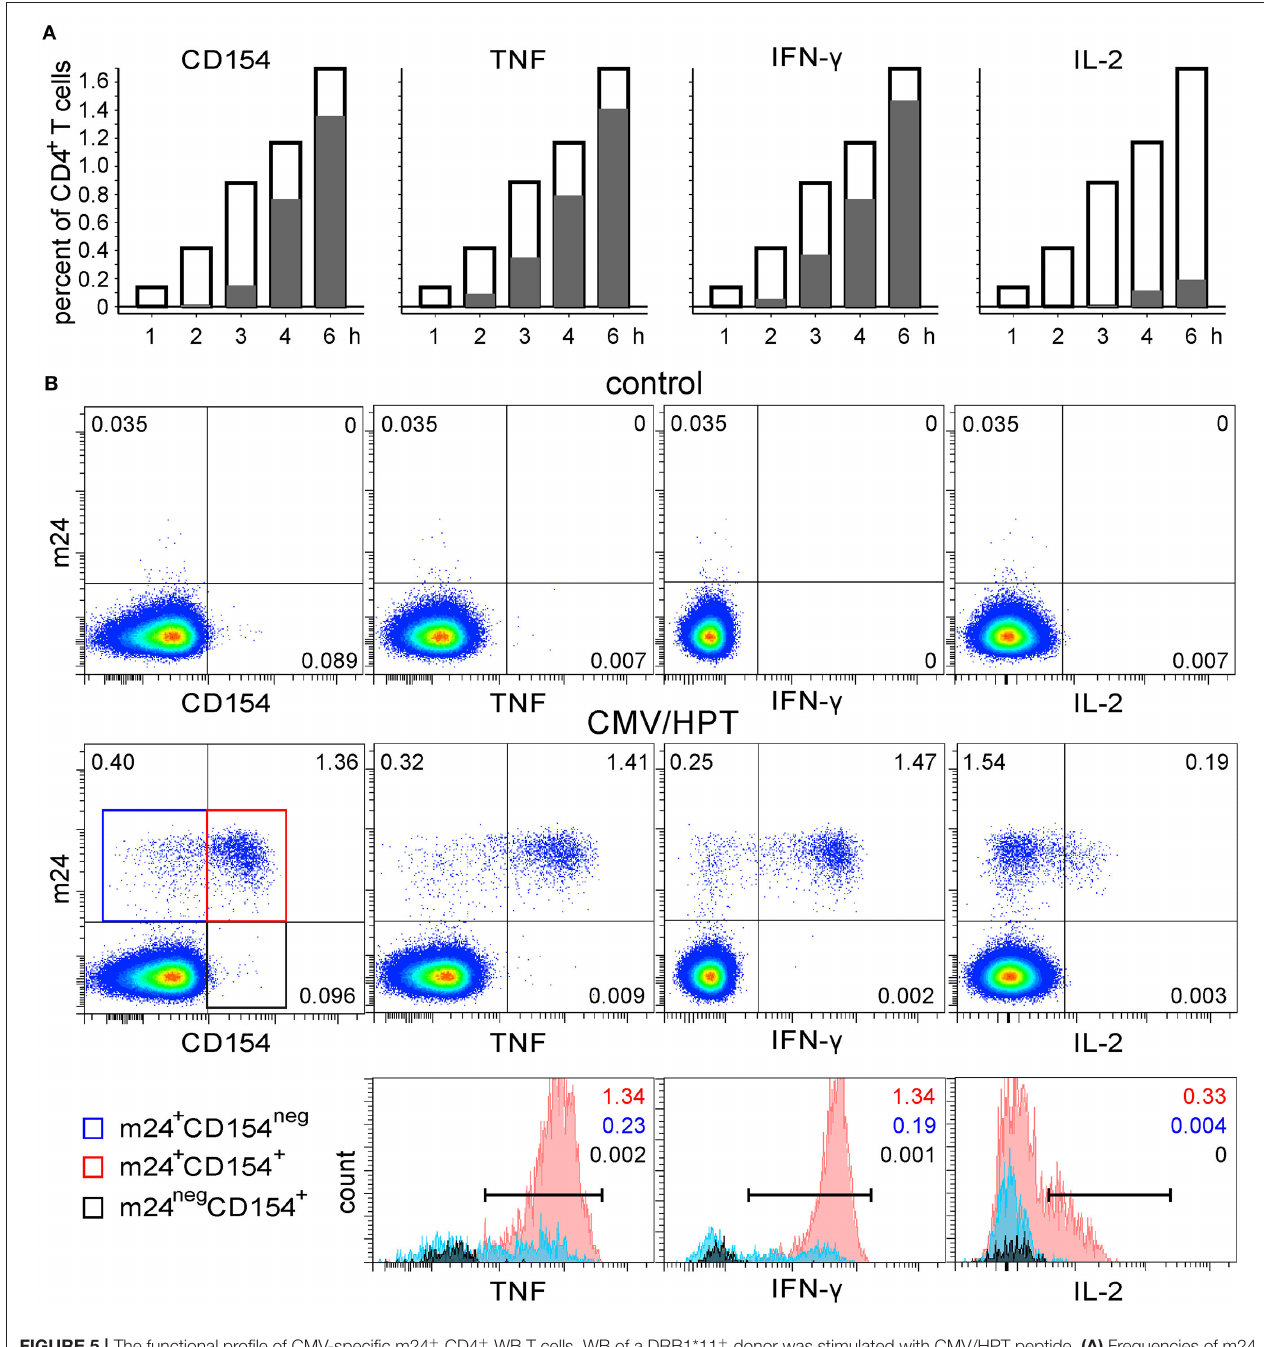
stimulation (0–0.001%, exemplary donor CoV-2 #3 is shown in Figure 7A top, pink frames). The addition of overlapping peptides derived from the membrane (M), N, or spike